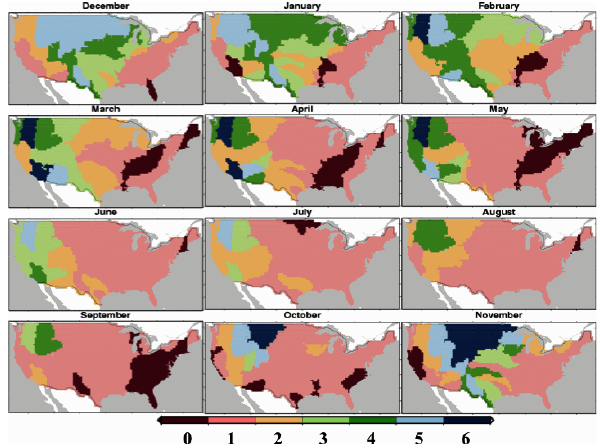
Fig. 6. Plot of the maximum lead (in months) at which RMSE Ratio is less than 1, for mean monthly SM forecasts, initialized on the beginning of each